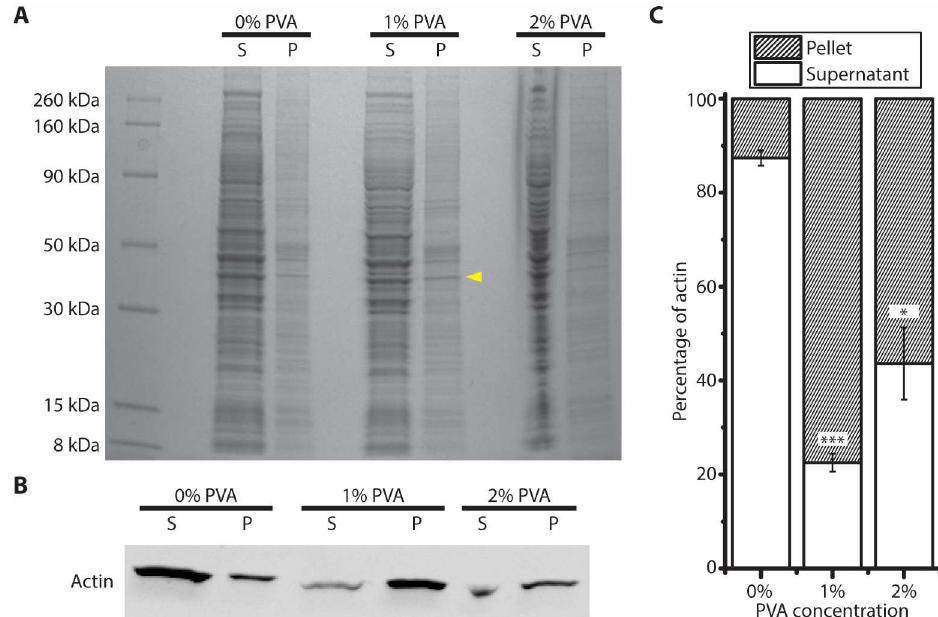
Fig 7. Actin aggregates with PVA surfactant. (A) Coomassie blue stained gel showingproteinsin the supernatant or pellet after 10 min centrifugationat 16,100g, in the presenceof PVA surfactant at different concentrations. (B) Western blot showingthe actin in the supernatant or pellet fractions at different PVA concentrations. (C) Percentageof actin measuredin the supernatant and pellet fractions at different PVA concentrations (n = 3, ± S.E.), unpairedt test comparingwith 0% PVA; * : p < 0.01; *** : p <